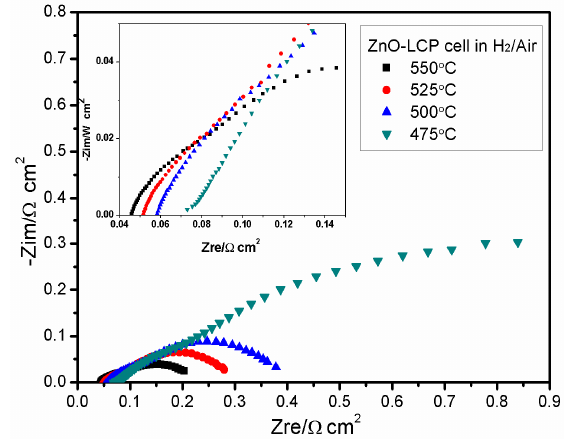
Figure 8. Impedance spectra of ZnO-LCP fuel cell acquired in H 2 /air at various temperatures.